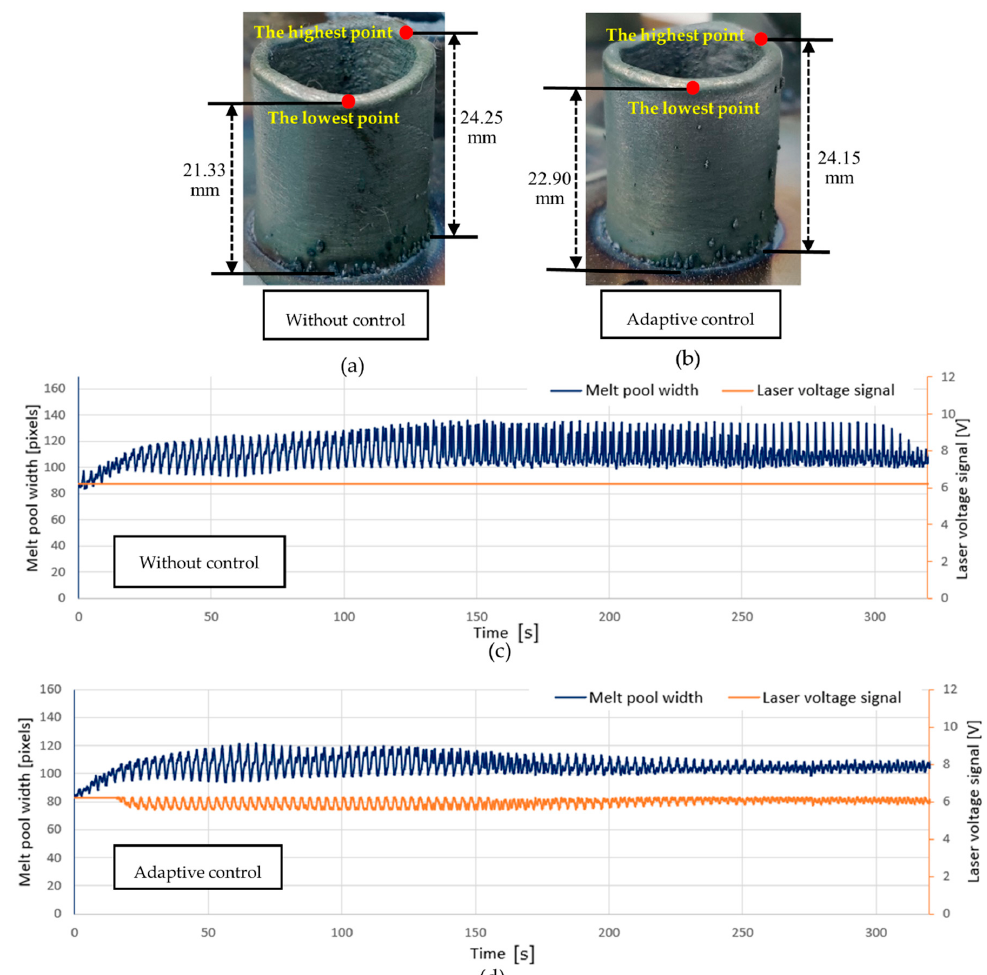
Figure 10. Results of Experiment 3 (thin-walled hollow pipes with a spiral tool path, LPW-35N nickel alloy). ( a ) The sample fabricated without control; ( b ) The sample fabricated with adaptive control; ( c ) The MPW and laser voltage plots for the uncontrolled sample; ( d ) The MPW and laser voltage plots for the adaptively controlled sample.